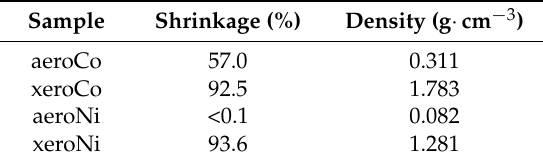
Table 1. Shrinkage degrees and density values for aerogels and xerogels monoliths.